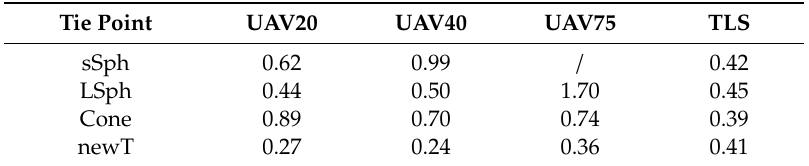
Table 9. The RMSE 2 D of the check points following the UAV and TLS point cloud registration into the referential measurements performed with MS50, provided in cm.